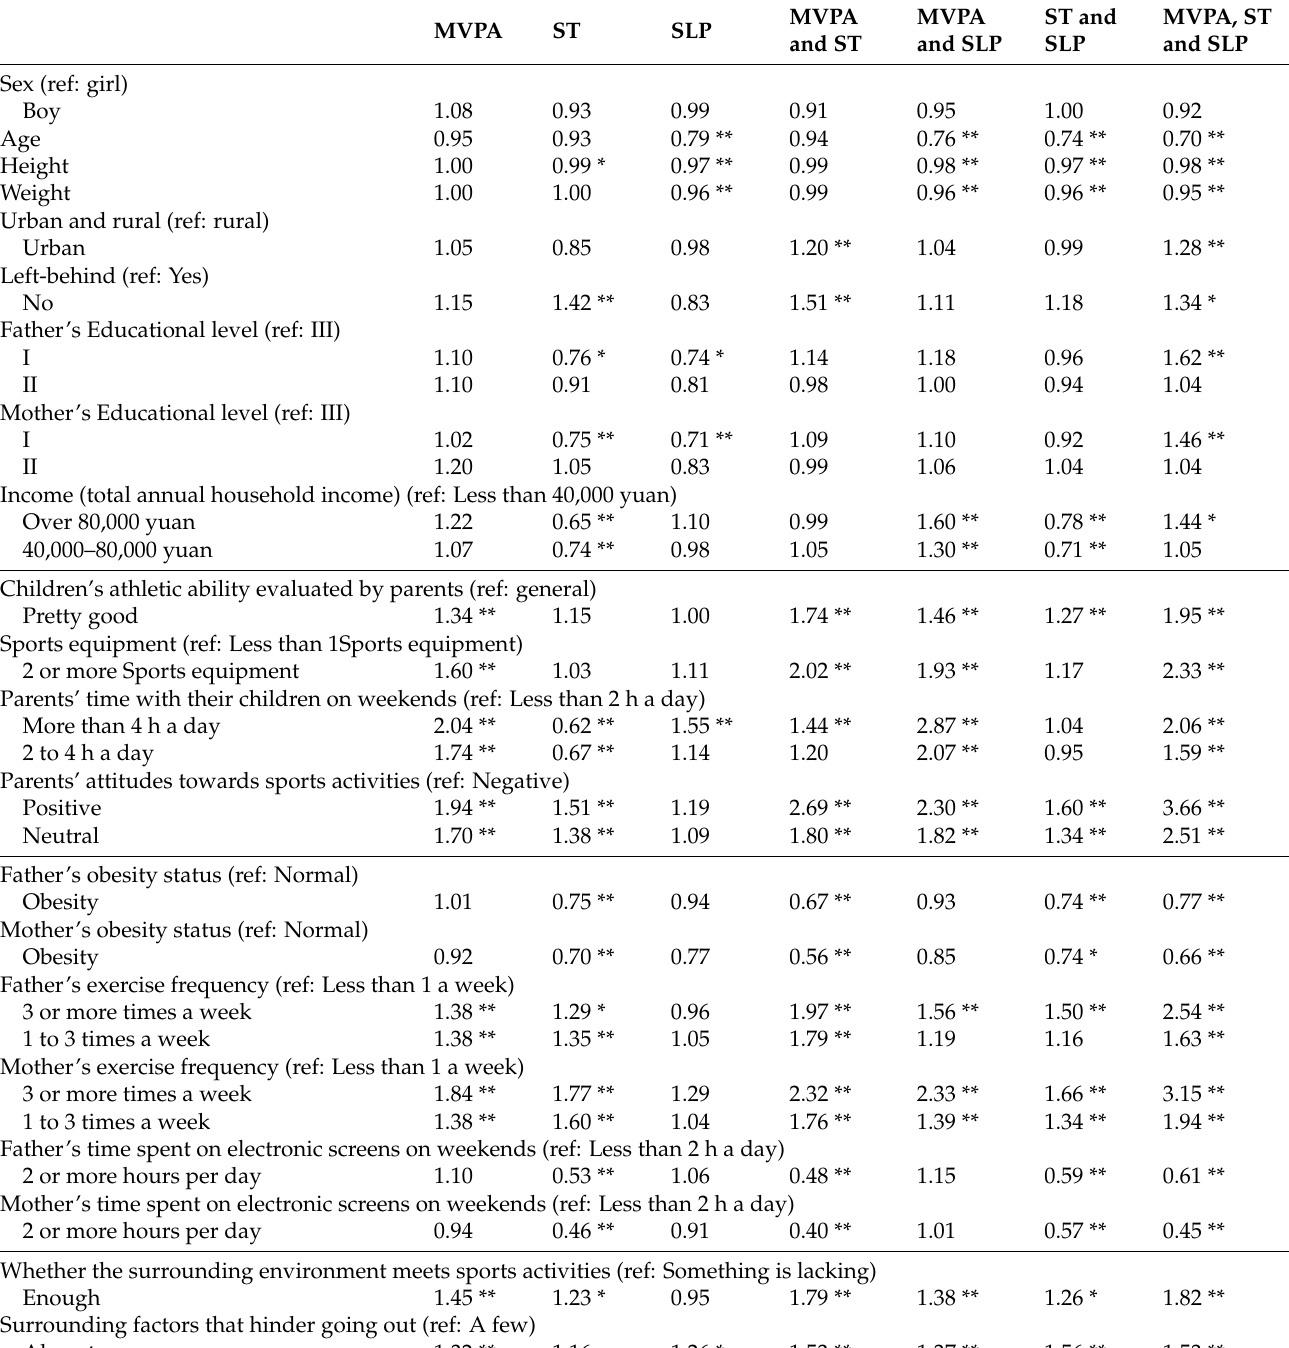
Table 4. The OR values for the eight combinations of three health-related behaviors. MVPA ST SLP and